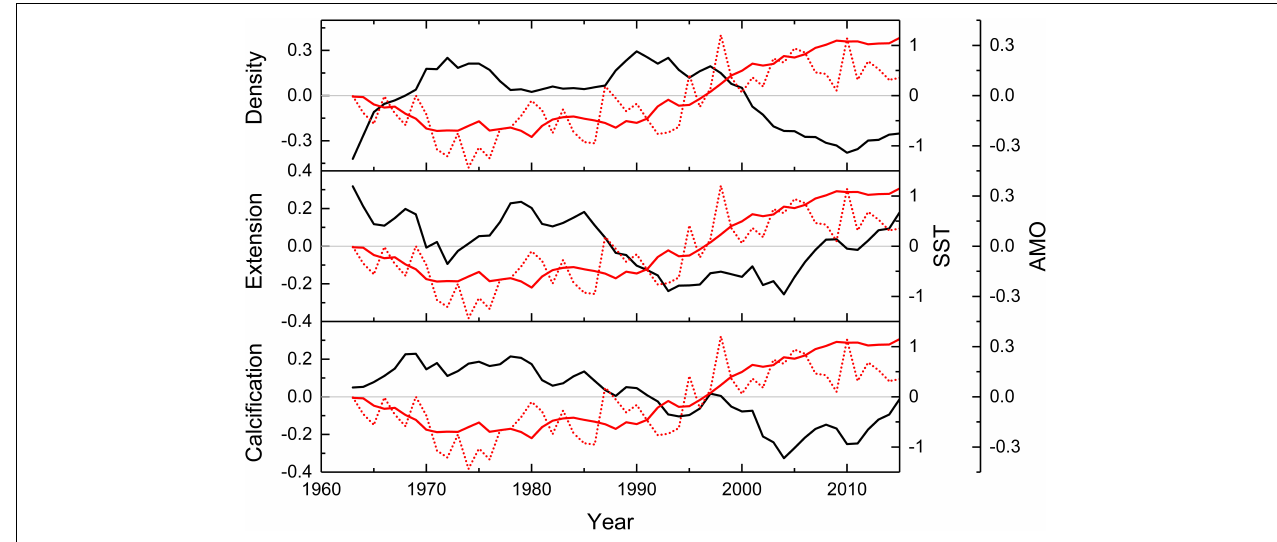
FIGURE 3 | Coral growth, SST and AMO correlations. Values of coral growth parameters (black solid lines) and SST (red solid lines) are presented as 13-year smoothed standardized anomalies (STDA). AMO is represented by red dotted lines. Density and calcification are negatively correlated with cyclical temperature